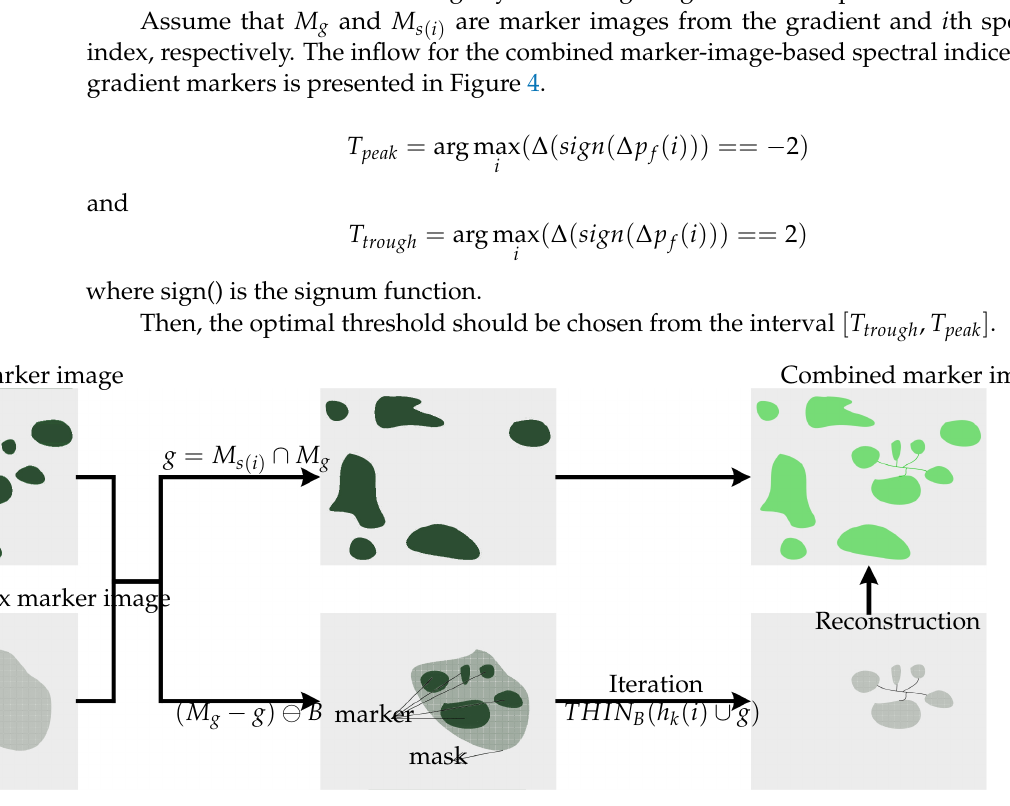
Figure 4. Inflows of generating combined marker-image-based spectral index and gradient